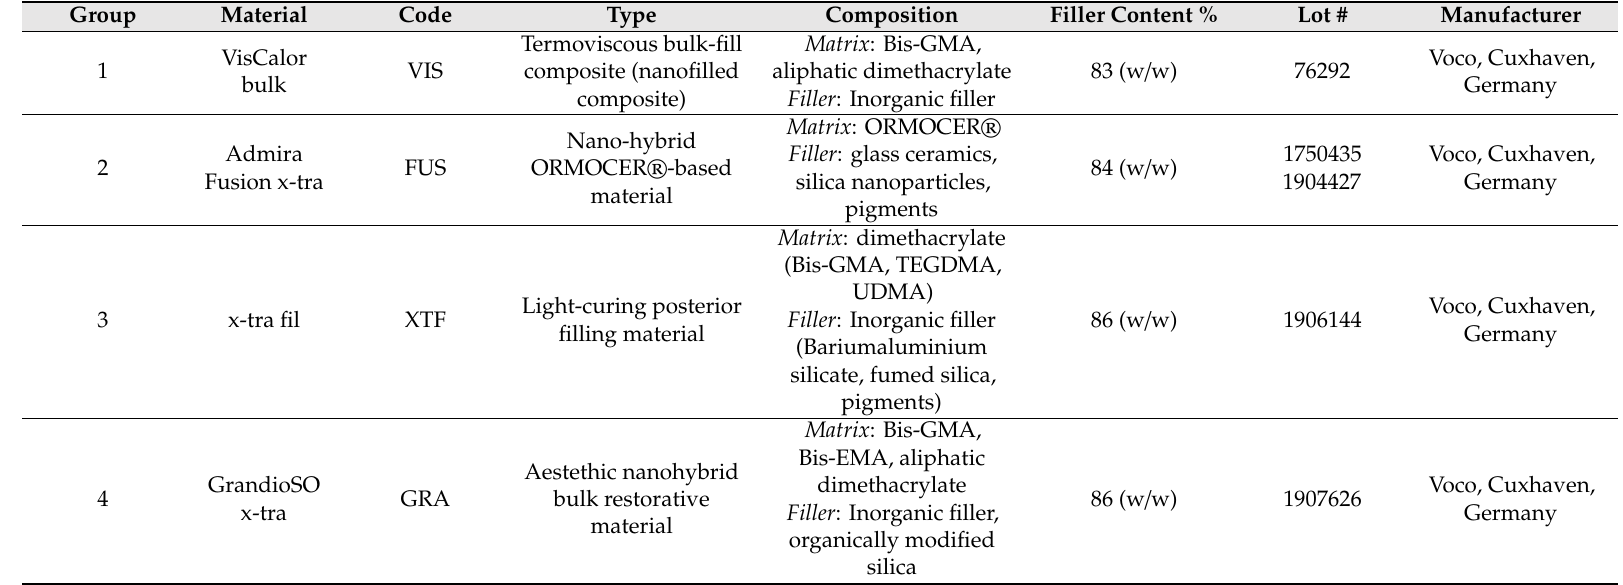
Table 1. Characteristics of the materials tested in this